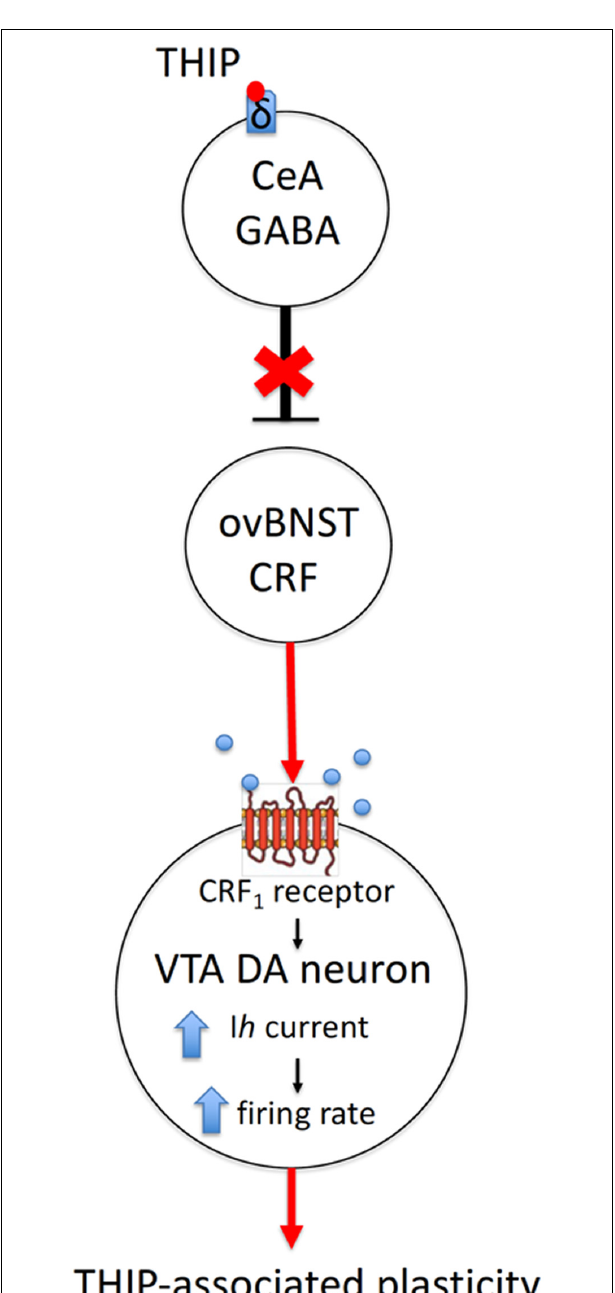
FIGURE 5 | A hypothetical mechanism of action of sedative doses of THIP on the δ -GABA A receptors, followed by activation of CRF neurons in the ovBNST and persistent neuroplasticity in DA neurons of the VTA. Briefly, THIP selectively activates the ovBNST CRF neurons via disinhibition of one of the GABAergic inputs to ovBNST, which are enriched with δ -GABA A receptors (e.g., in the central nucleus of amygdala, CeA). The release of CRF on VTA DA cells and signaling through CRF 1 receptor/PKC/HCN pathway might increase firing rate and induce excitatory synapse neuroplasticity in VTA DA neurons. δ -GABA A receptors (Herman et al., 2013). This